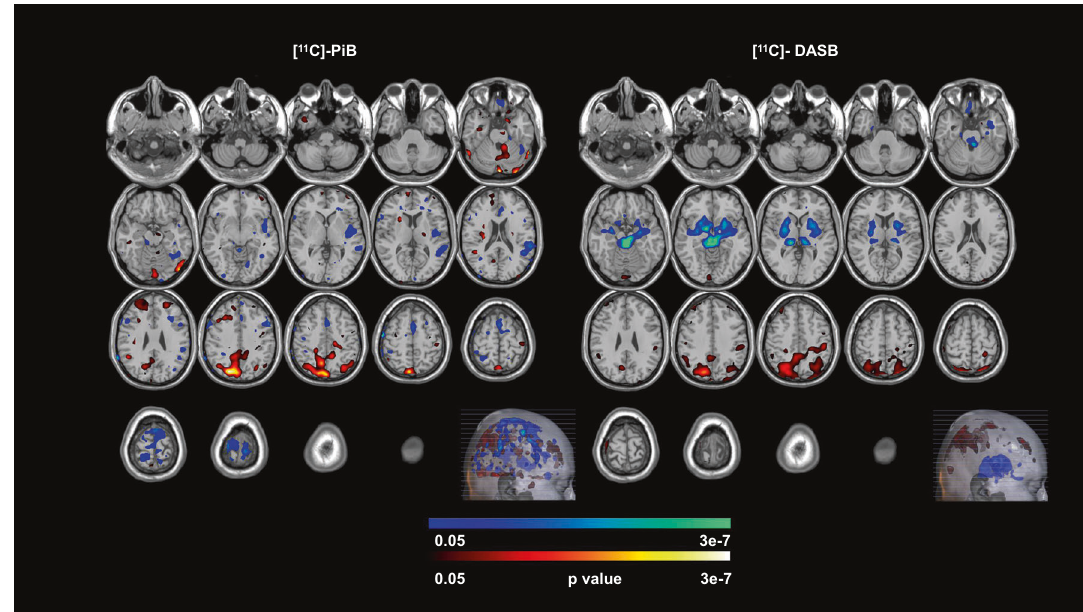
Fig. 3 Co-varying spatial patterns between beta-amyloid deposition and serotonin transporter availability. Covarying Spatial patterns determined by Multi-Modal Partial Least Squares in normal controls and late-lifedepressed